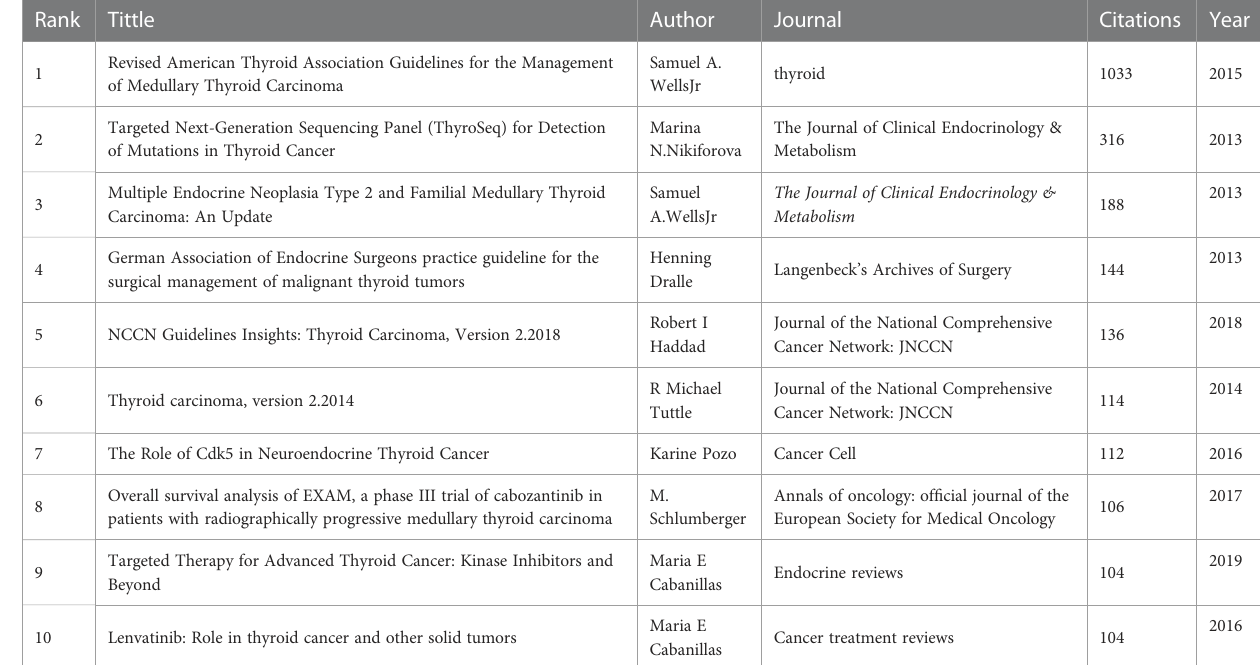
TABLE 6 Top 10 highly cited documents in the MTC research fi eld.